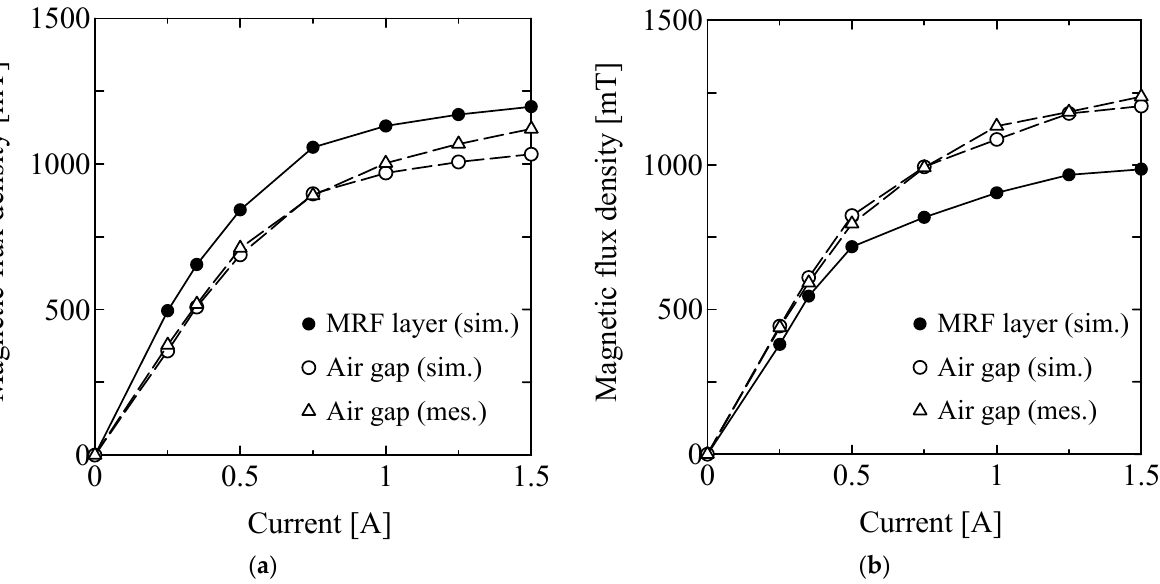
Figure 11. Analytic results on current vs. magnetic field. ( a ) Parallel plate, ( b ) V-shaped plate.